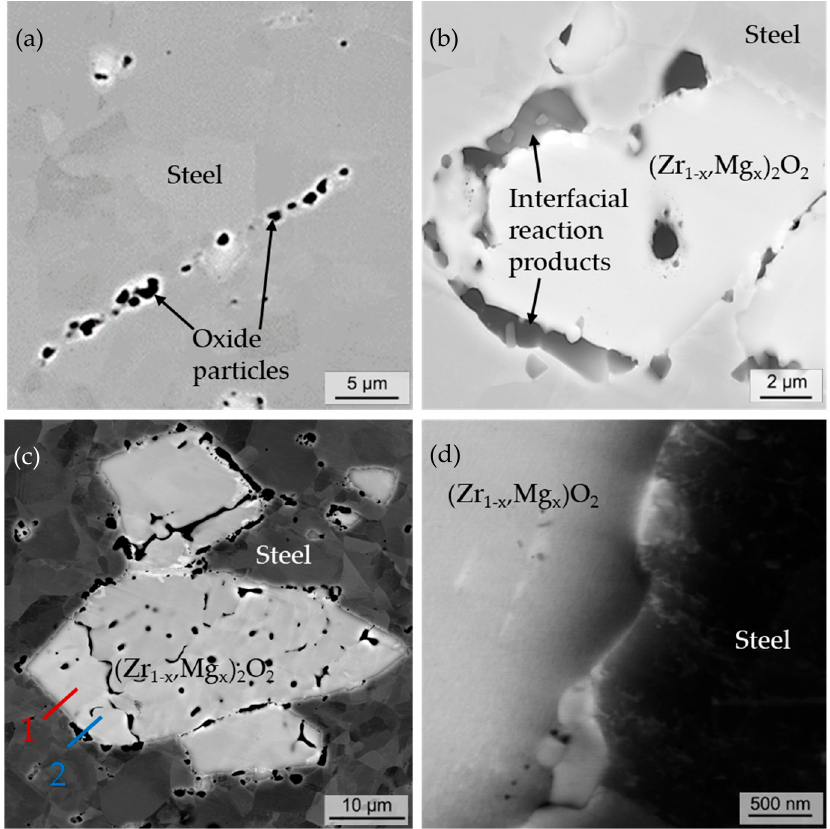
Figure 8. SEM images based on backscattered electrons: ( a ) necklace-like oxide particles (magnification: 1000 × ), ( b ) zirconia particle with distinct reaction layer at interface with steel matrix (magnification: 5000 × ), ( c ) characteristic microstructure of composite (two EDS line scans across interface are highlighted; magnification: 1500 × ), and ( d ) interface without reaction layer; dislocations are visible next to interface of composite (magnification: 25,000 × ). Metals 2020 , 10 , x FOR PEER REVIEW